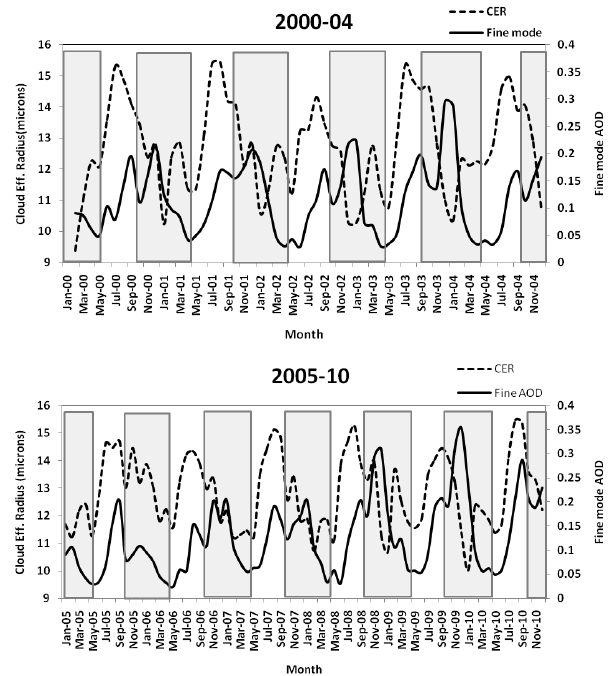
Fig. 2. Monthly mean time series between fine mode AOD and CER. The rectangular boxes indicate the dry months when fine mode AOD and CER shows a negative relation.